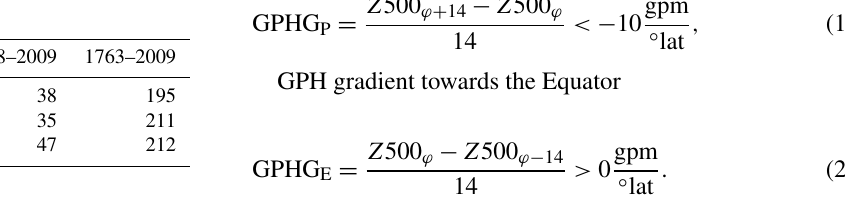
Figure 2. CAP7 1763–2009 JFM mean frequency of occurrence. Table 2. Size (number of months) of each solar activity level and periods